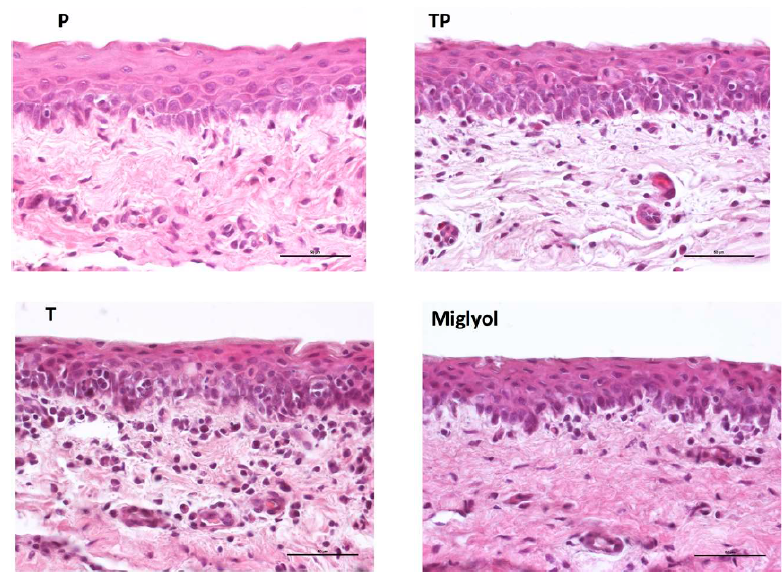
Figure 6. Histology of the conjunctival samples treated for 5 h with the different formulations. (Magnification 40×, bar = 50 µm).